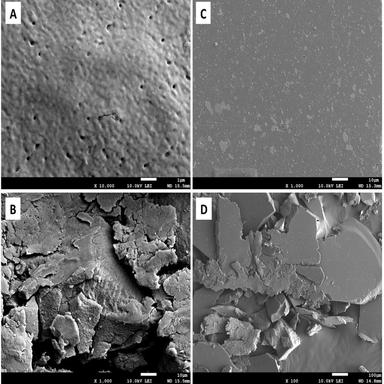
SEM image of the pristine and (A, B) ground (C, D) structures of CNC.